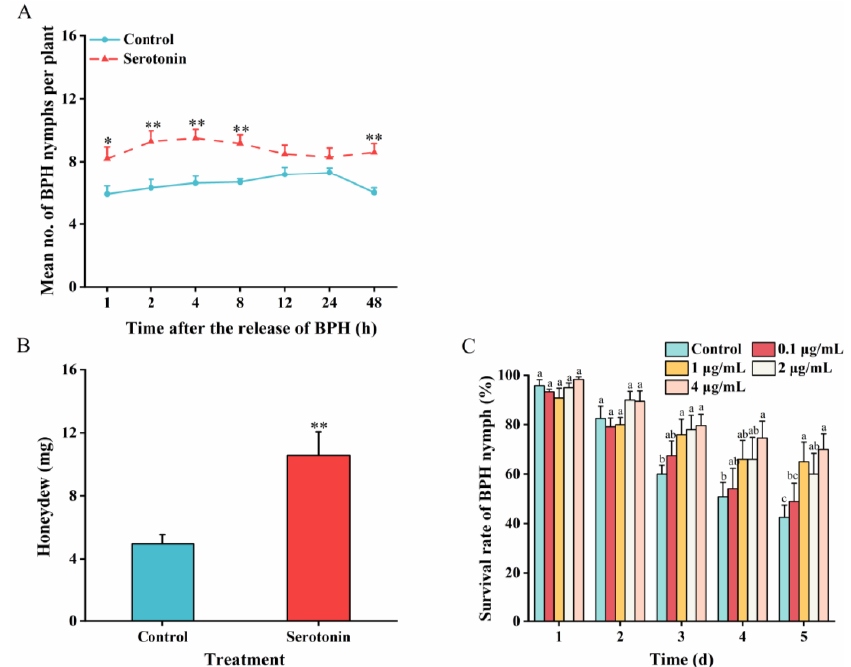
Figure 4. Effects of exogenous serotonin on the performance of BPH nymphs. ( A ) Host choice selectivity of BPH on serotonin-treated or control plants; ( B ) honeydew excretion of BPH on serotonin- treated or control plants; ( C ) survival rate of BPH nymphs fed on artificial diet containing varied concentrations of serotonin. Values are means + SE. Asterisks indicate significant differences between treatments (*, p < 0.05; **, p < 0.01; Student’s t -test). Different letters represent significant differences among treatments (One-way ANOVA followed by LSD test).